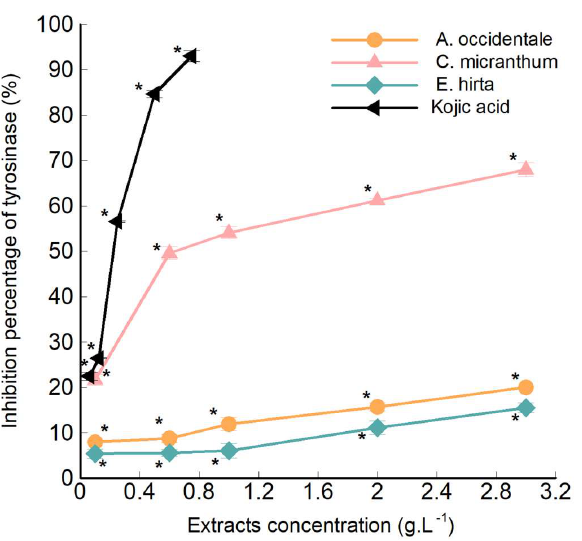
Figure 4. In tubo tyrosinase activity assays results for Combretum micranthum leaves, Euphorbia hirta plant and Anacardium occidentale fruits aqueous extract with kojic acid solution used as reference. * p < 0.05 indicates a significant difference between aqueous extract test and negative control.